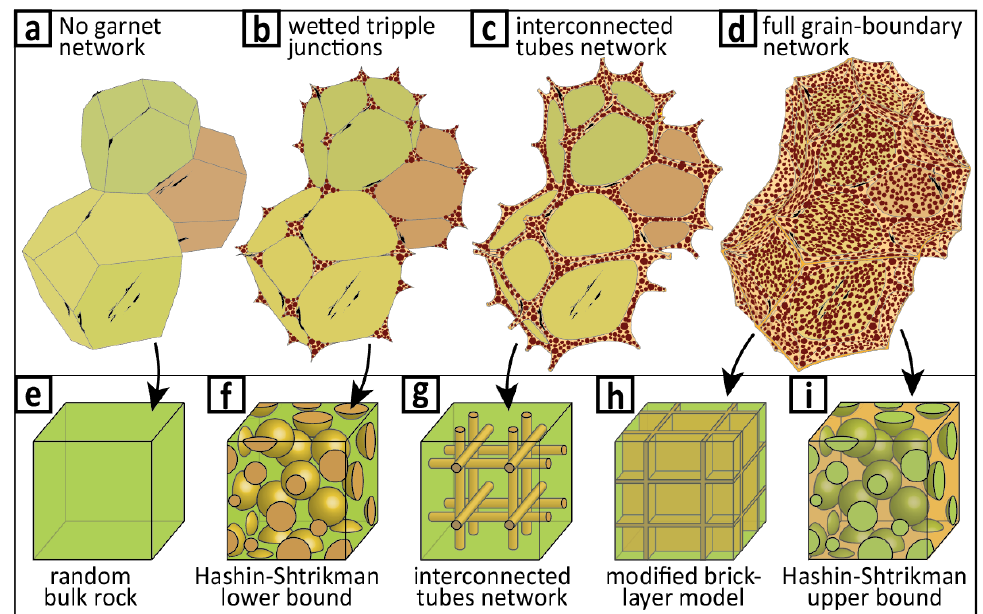
Figure 6. Representation of the different physical models used for electrical conductivity simulations. Sketches of the grains with variable geometries of the garnet networks ( a – d ) and corresponding simplified geometries used for the physical models ( e – i ) presented in Figure 7. Drawings ( a , b ) and ( d ) were adapted from Case ( c ), inspired from [53]. Garnet is represented in dark red, and possible local graphite impurities are represented in black.